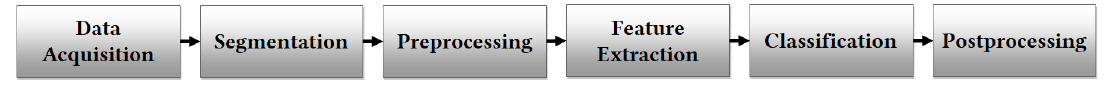
Figure 3. The six stages of the standard structure of the